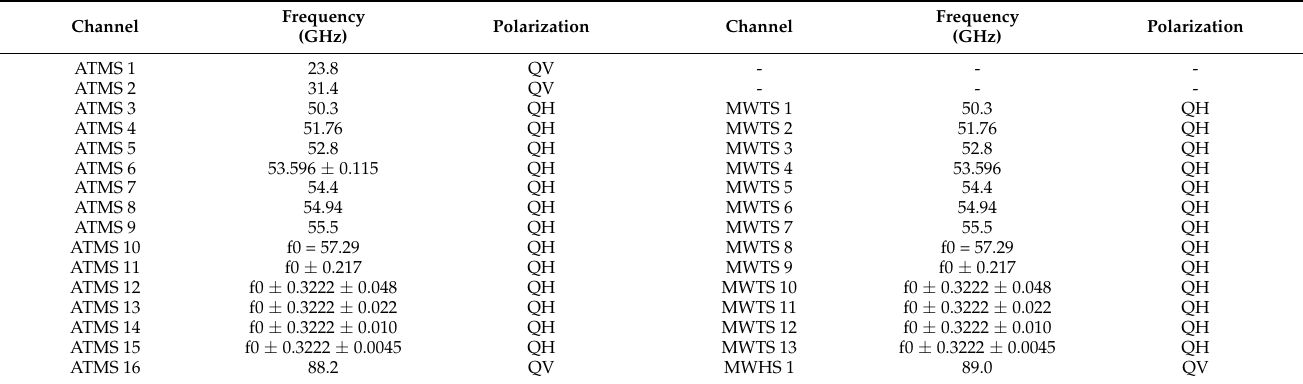
Table 1. Specific comparisons between channel characteristics for ATMS, MWTS-2 and MWHS-2.